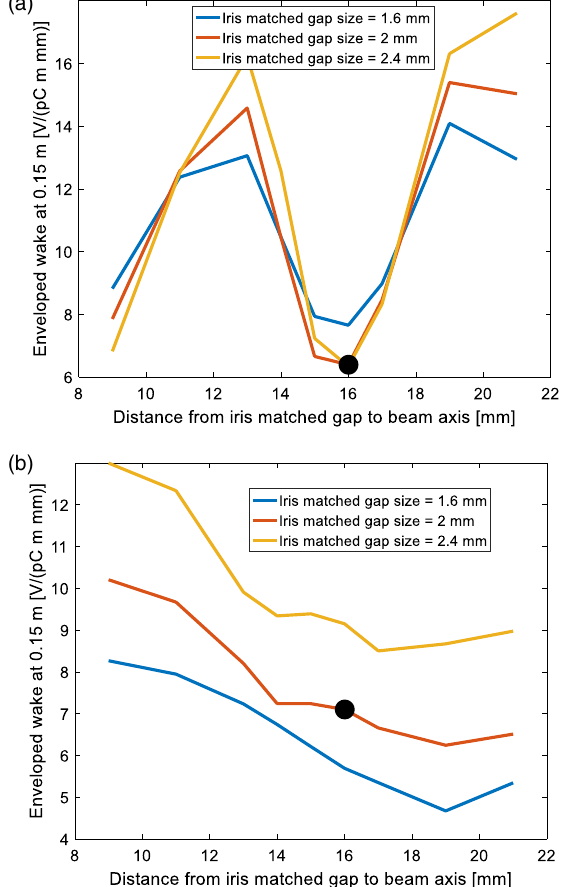
FIG. 12. Dependence of wakefield suppression on the iris matching step ( g in Fig. 6): (a) Wx ; (b) Wy . The solid point m represents the optimum choice.